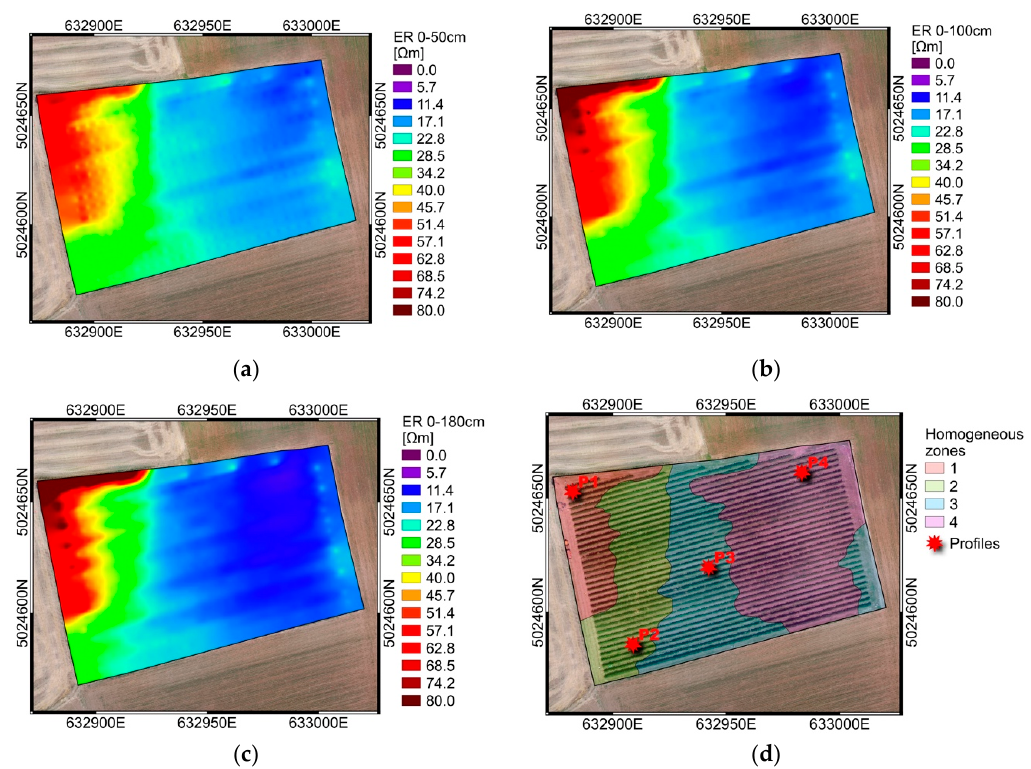
Figure 3. Maps obtained from the electrical resistivity (ER) survey: ( a ) ER map for the 0–50 cm depth; ( b ) ER map for the 0–100 cm depth; ( c ) ER map for the 0–180 cm depth; ( d ) homogeneous zones obtained after statistical analysis and pedological profiles locations. The pixel size of interpolation maps reported from ( a ) to ( c ) is 20 × 20 cm.